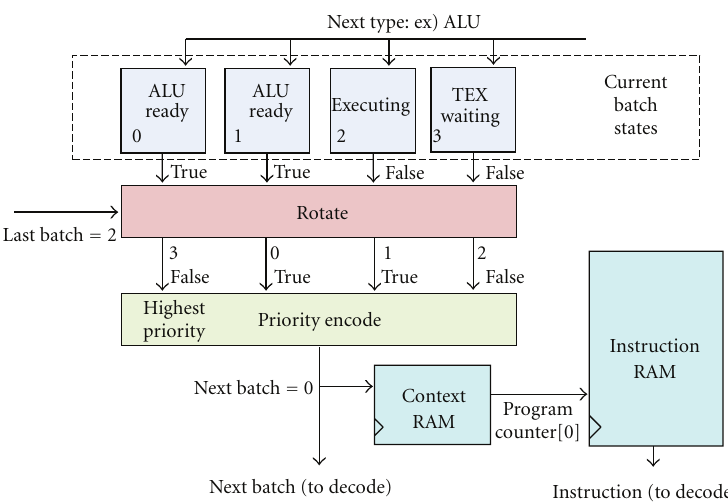
Figure 9: Batch issue logic for hardware managing 4 batch contexts.